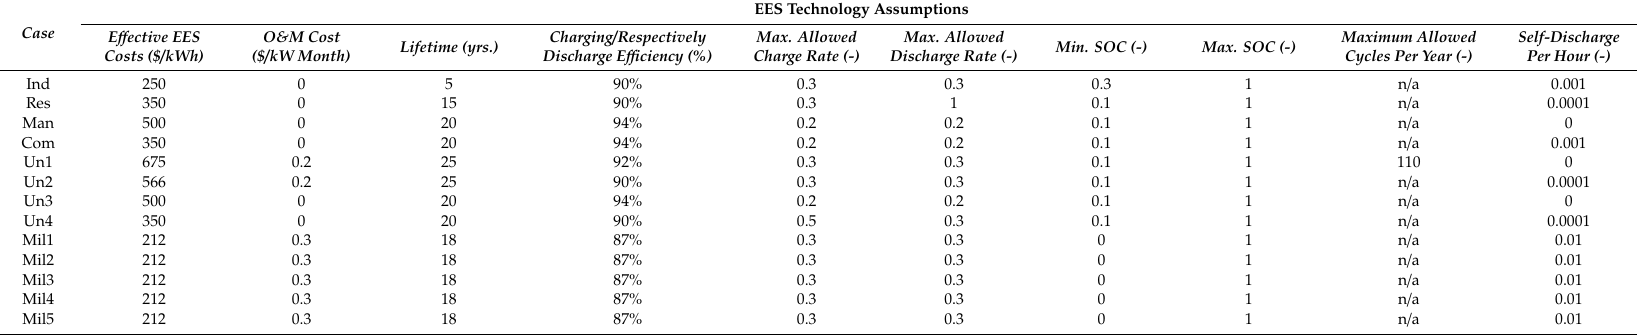
Table A3. Electric Energy Storage (EES) technology assumptions. The max. allowed charging and discharging rates are constraints within the MILP. Max allowed charge and discharge rates are defined as a function of the EES power capacity.